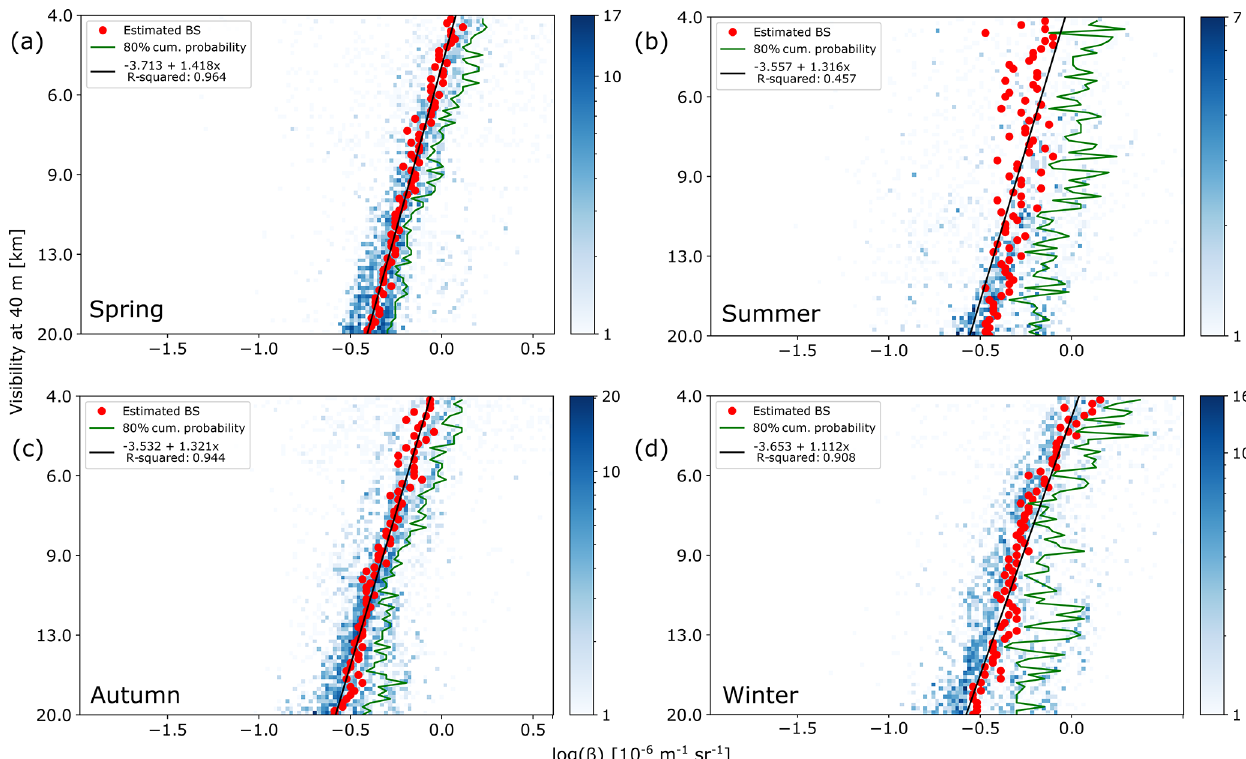
Figure 9. Cabauw data histograms split by seasons for visiometer height 40ma.g.l. (a) Spring. (b) Summer. (c) Autumn. (d)